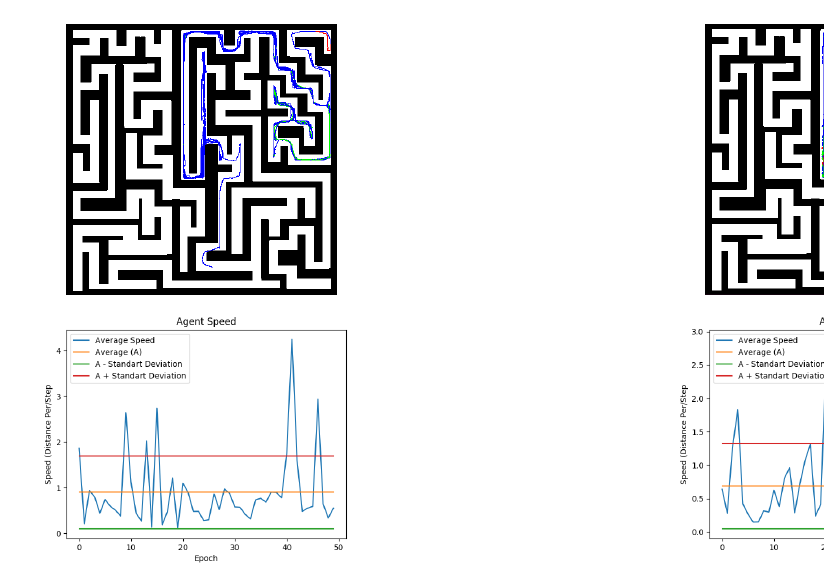
Figure 15. (a) The agent emotional state, and (b) the agent speed with the emotional model’s configurations equal to that shown in row 2 of Table 5.